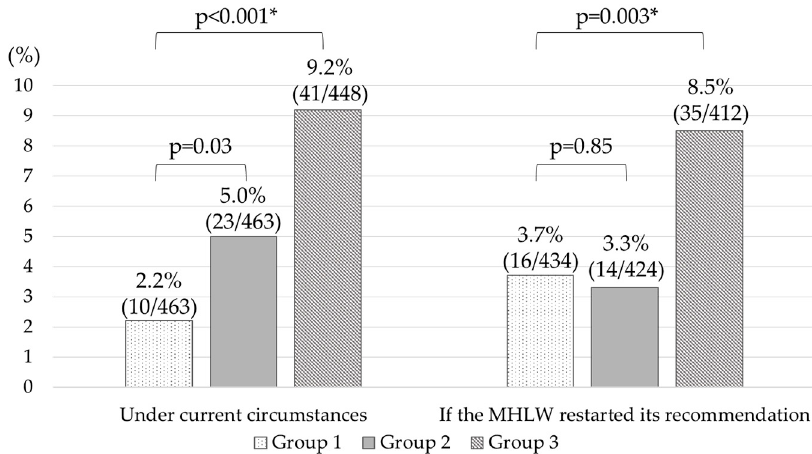
Figure 1. Leaflet intervention effect. In the mothers who had no intention to suggest vaccination to their daughter under the current circumstances, 9.2% (41/448) of Group 3 became newly willing to inoculate their daughters after intervention with our leaflets. This increase was significantly higher than the 2.2% (10/463) of Group 1 ( p < 0.001). If the MHLW restarted their recommendation, 8.5% (35/412) of Group 3 turned willing to inoculate their daughters after intervention with the leaflets. Compared to 3.7% (16/434) of Group 1, the increase in the rate of Group 3 was significantly higher ( p = 0.0037). * Significant difference was set to p < 0.025 due to a multiple comparison correction.